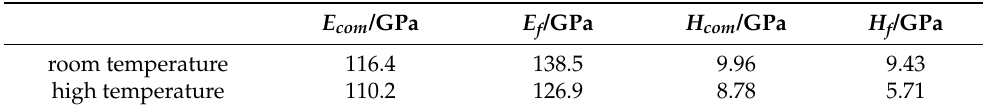
Table 1. The composite and intrinsic mechanical parameters of VO 2 films.